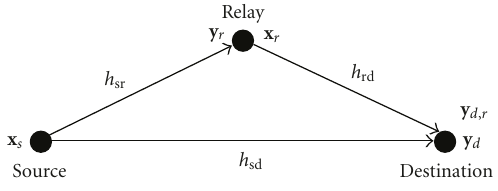
Figure 1: Three-node relay network